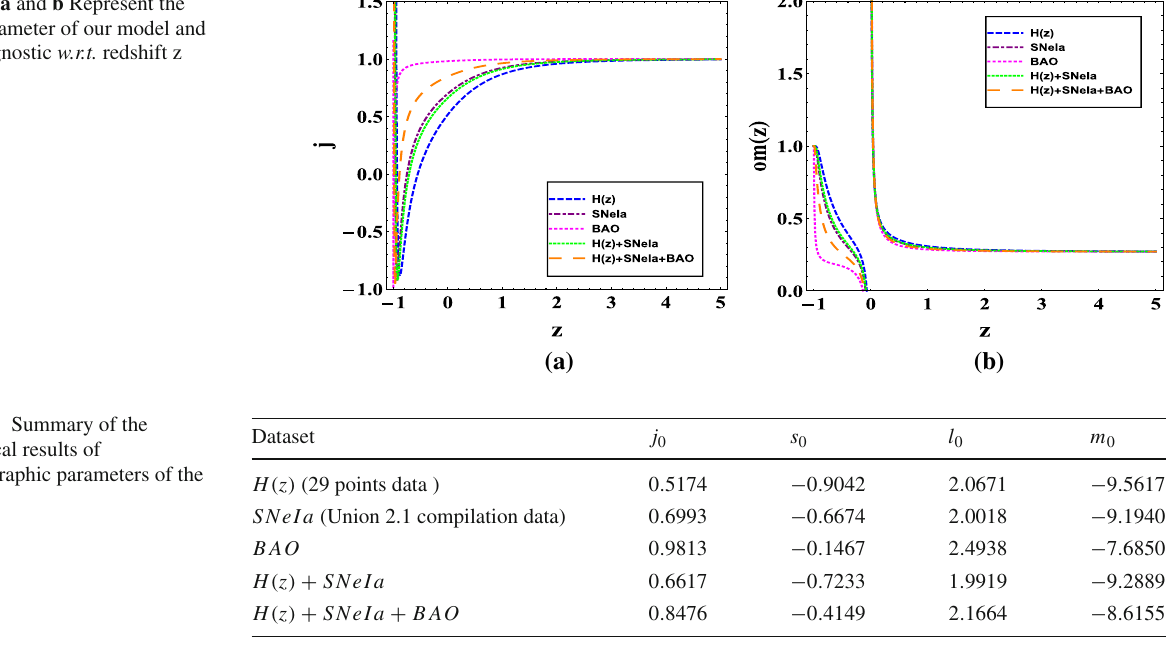
Fig. 8 a and b Represent the jerk parameter of our model and om diagnostic w.r.t. redshift z